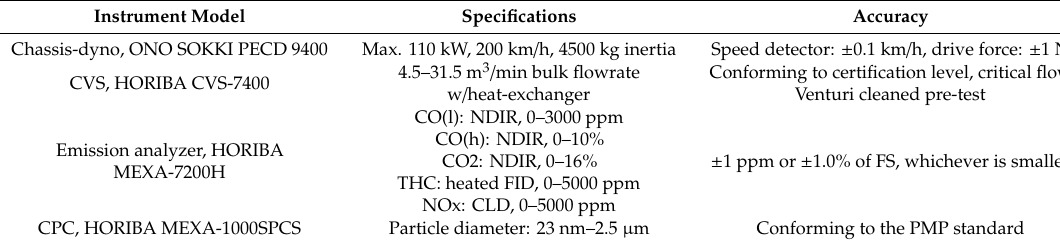
Figure 1. Configuration of the test system. Table 1. Specifications of the test instruments.